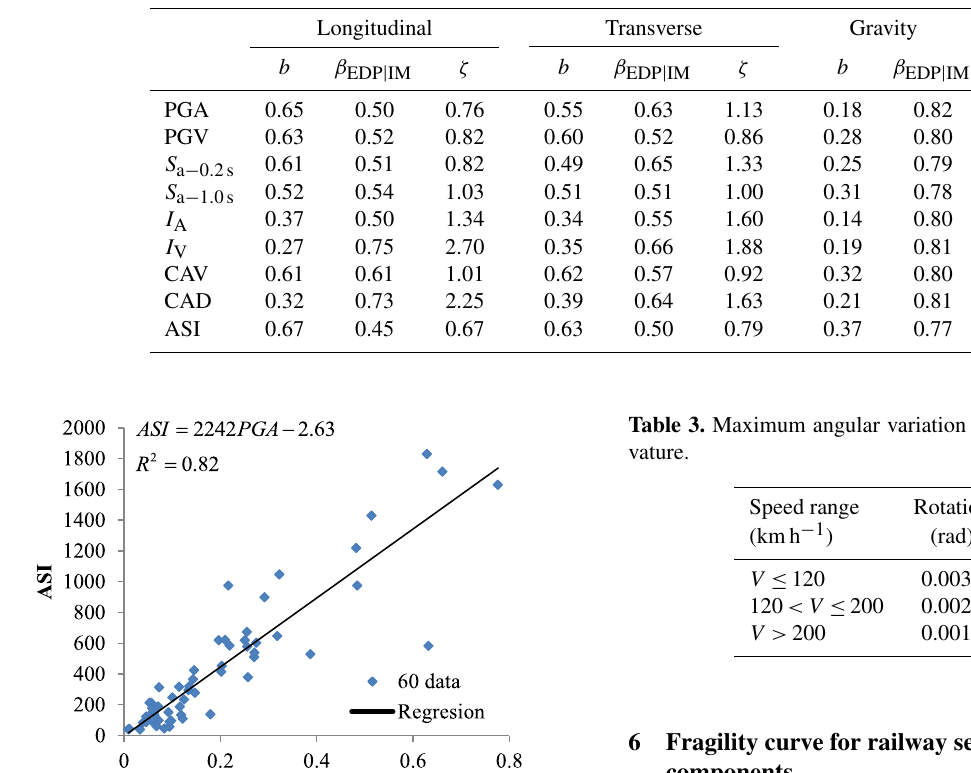
Table 2. Demand models and intensity measure comparisons.